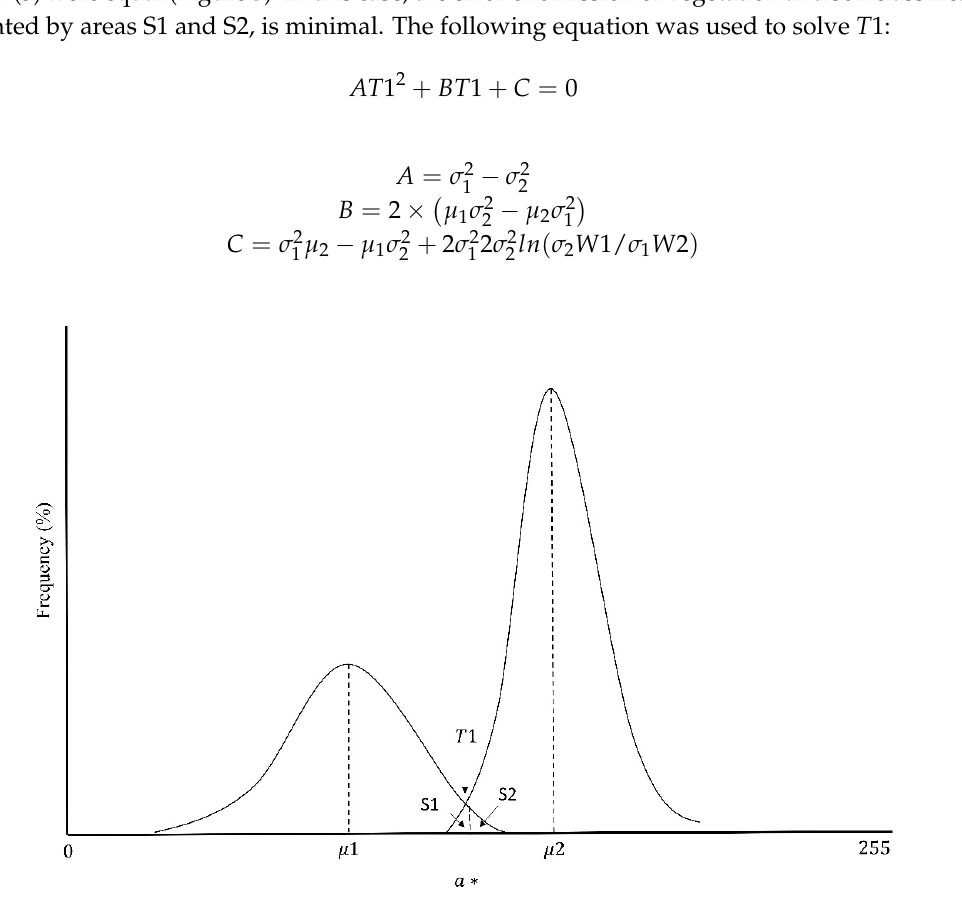
Figure 6. Flowchart for estimating the cover of vegetation vertical strata at sampling sites in the State of Mexico.